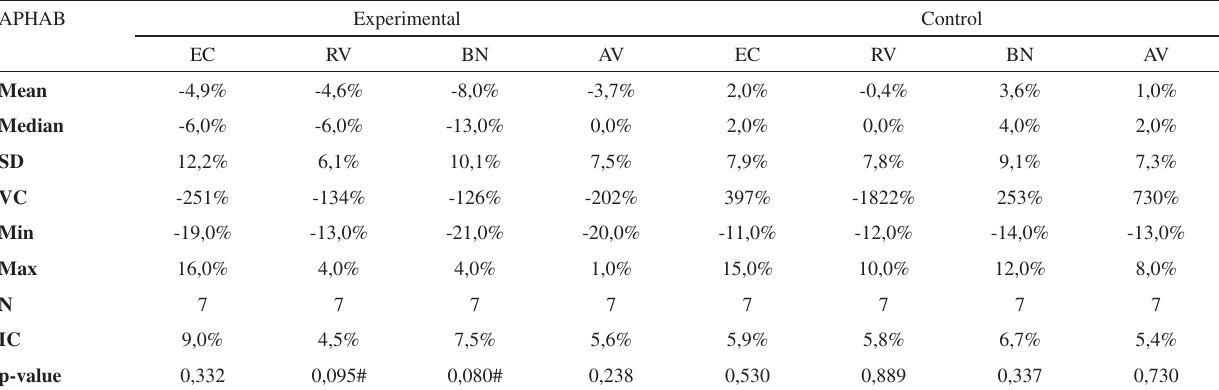
Table 6 - Benefit observed in APHAB for control and experimental groups comparing pre- and post-training administration APHAB Experimental